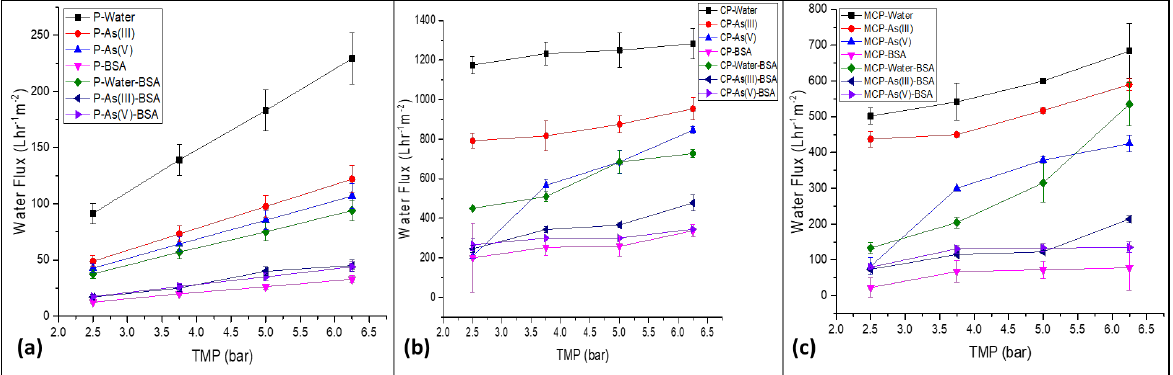
Figure 2. Water flux of the membranes ( a ) P, ( b ) CP, and ( c ) MCP as a function of TMP for pure and contaminated water during BSA filtration for antifouling study.